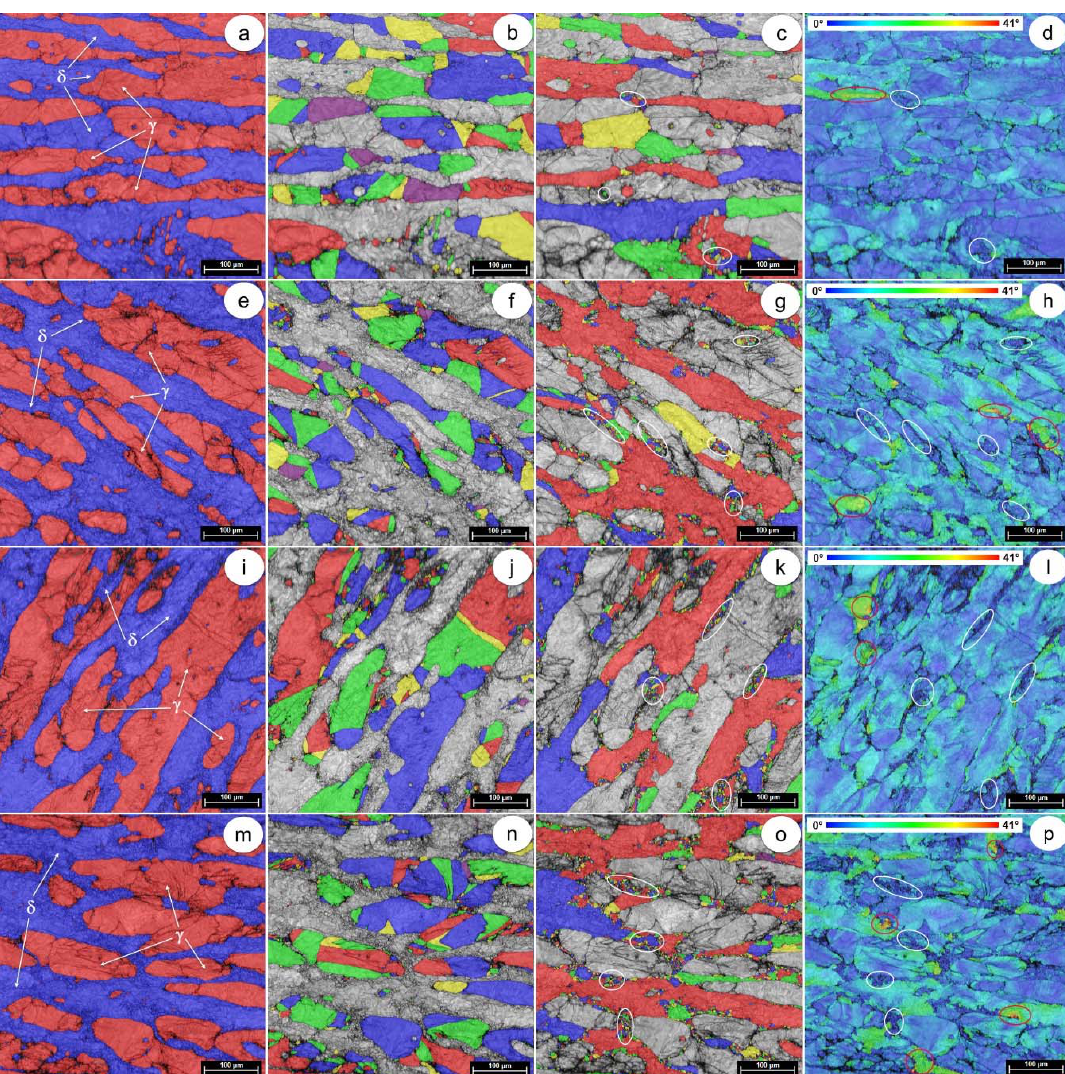
Figure 4. SEM-EBSD composite images for the UNS 32750 alloy deformed at 1050 ◦ C by ε = 10%: γ Figure 4. SEM ‐ EBSD composite images for the UNS 32750 alloy deformed at 1050 °C by ε = 10%:  and δ phase distribution ( a ); grain size, shape and distribution for γ -phase ( b ) and δ -phase ( c ); GROD and δ phase distribution ( a ) ; grain size, shape and distribution for  ‐ phase ( b ) and  ‐ phase ( c ); GROD map distribution for both  and  phases ( d ); ε = 20%:  and δ phase distribution ( e ); grain size, shape map distribution for both γ and δ phases ( d ); ε = 20%: γ and δ phase distribution ( e ); grain size, shape and distribution for  ‐ phase ( f ) and  ‐ phase ( g ); GROD map distribution for both  and  phases ( h ); and distribution for γ -phase ( f ) and δ -phase ( g ); GROD map distribution for both γ and δ phases ( h ); ε = 30%: γ and δ phase distribution ( i ); grain size, shape and distribution for γ -phase ( j ) and δ -phase ε = 30%:  and δ phase distribution ( i ); grain size, shape and distribution for  ‐ phase ( j ) and  ‐ phase ( k ); GROD map distribution for both  and  phases ( l ); ε = 35%:  and δ phase distribution ( m ); grain ( k ); GROD map distribution for both γ and δ phases ( l ); ε = 35%: γ and δ phase distribution ( m ); grain size, shape and distribution for  ‐ phase ( n ) and  ‐ phase ( o ); and, GROD map distribution for both  size, shape and distribution for γ -phase ( n ) and δ -phase ( o ); and, GROD map distribution for both γ and  phases ( p ). and δ phases ( p